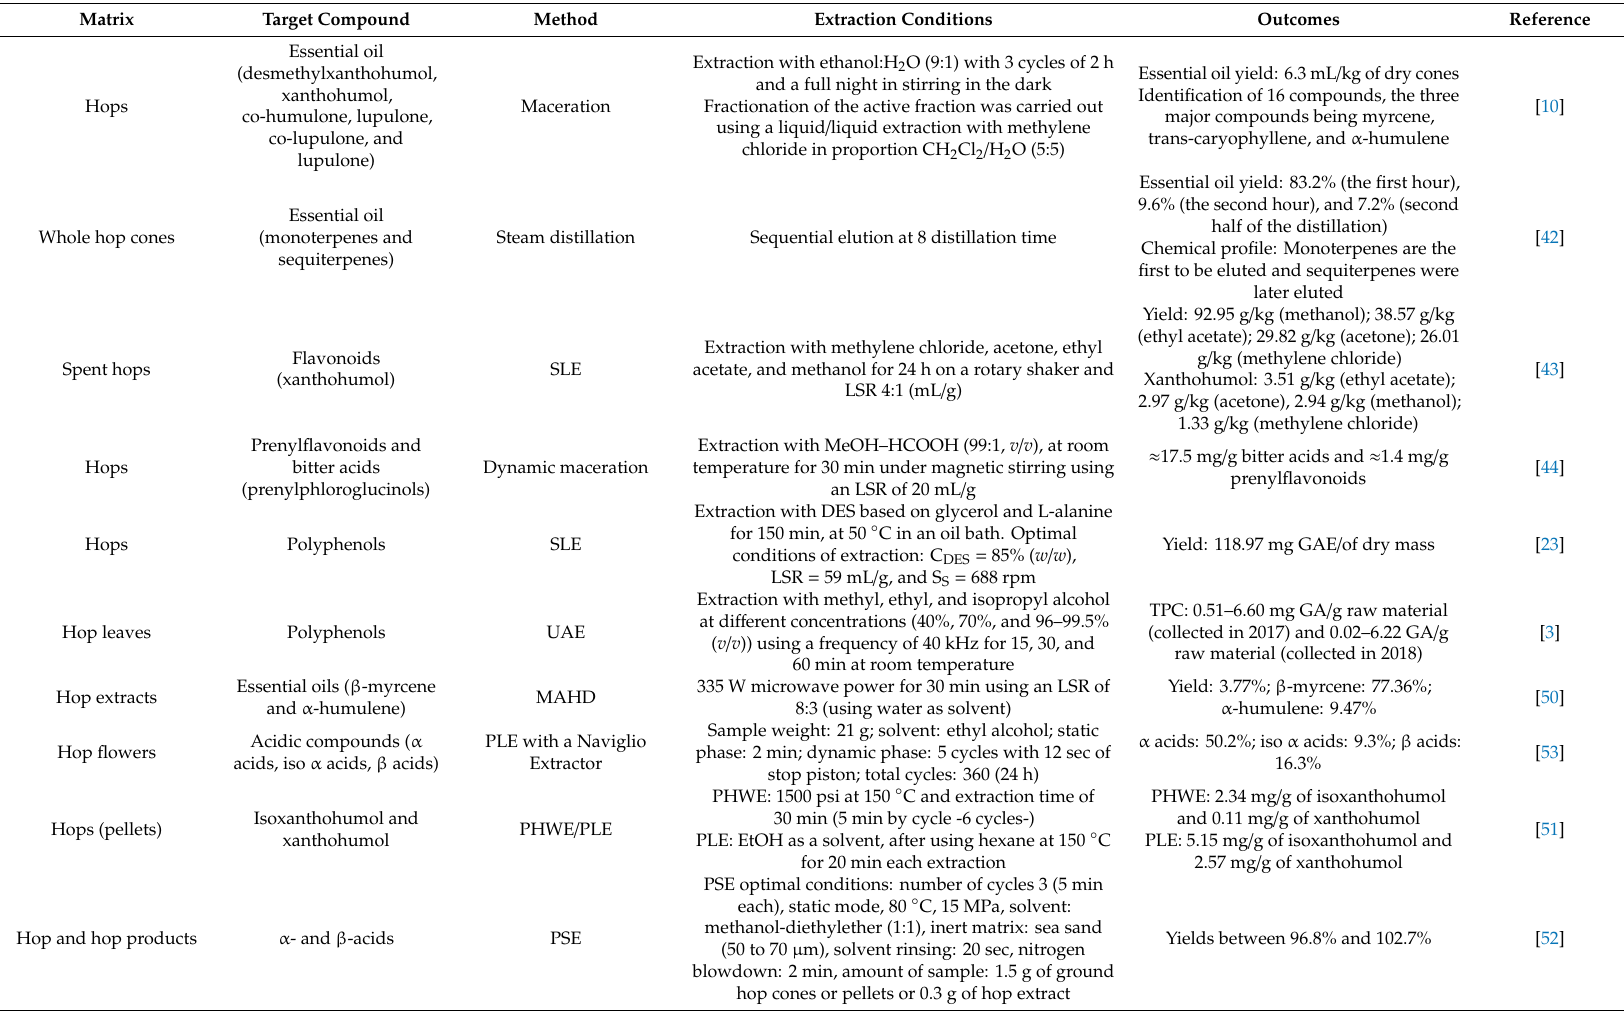
Table 1. Extraction technologies for obtaining active molecules from